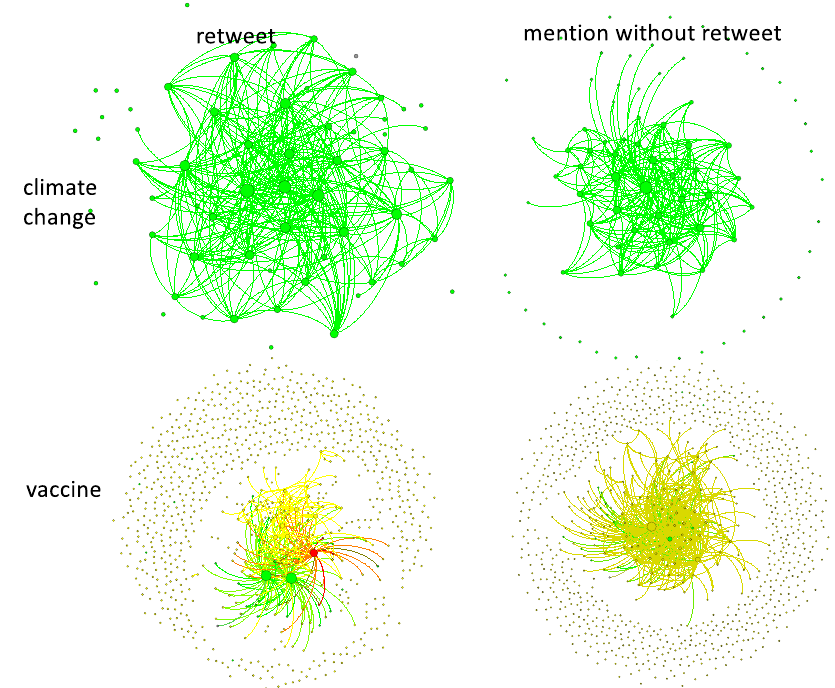
Fig. 2 Vaccine and climate community networks exhibit distinct structure. Network of communities formed by users tweeting 10 times or more in the climate change (top) and vaccine (bottom) conversations, for retweet (left) and mention (right) networks. Each node represents a community made up of two or more users. Edges represent interactions between the users: a member of one community has tweeted or mentioned a member of another community. The size of the node represents the size of the community, and the color of the node represents the most common sentiment of the users in each community: green represents pro-, red represents anti- and yellow represents